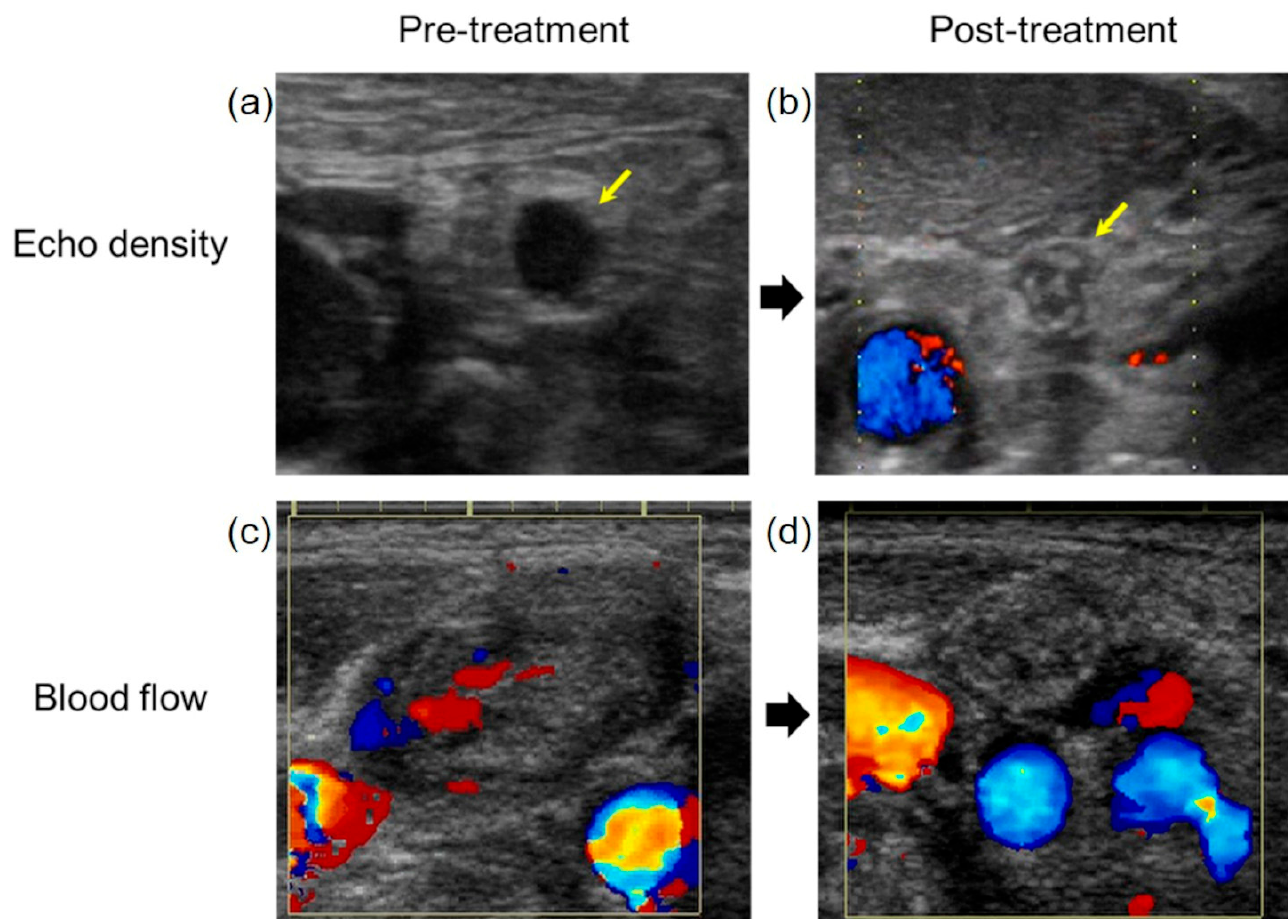
Figure 5. The evaluation of the treatment effect on metastatic lymph nodes. ( a ) The echo density of the metastatic lymph node was low before treatment. ( b ) The echo density changed to high after treatment (yellow arrow). ( c ) The blood flow of metastatic lymph node observed before treatment. ( d ) The blood flow to the metastatic lymph nodes disappeared after CRT.